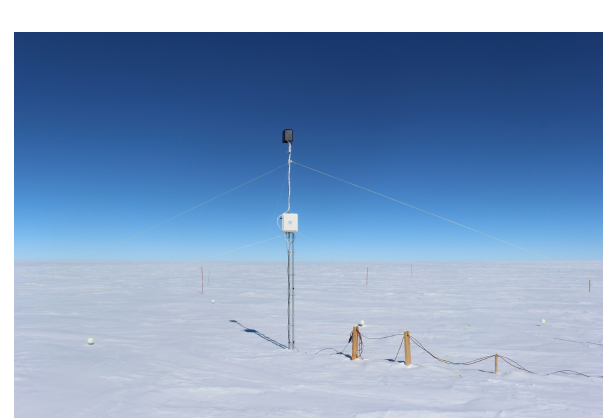
Figure 1. The RLS setup at Dome C (January 2017). The lasermeter and rotation mount are located under the black cap. The control is in the white box. The photograph looks southward, facing prevailing winds, and the scanned area is behind the RLS